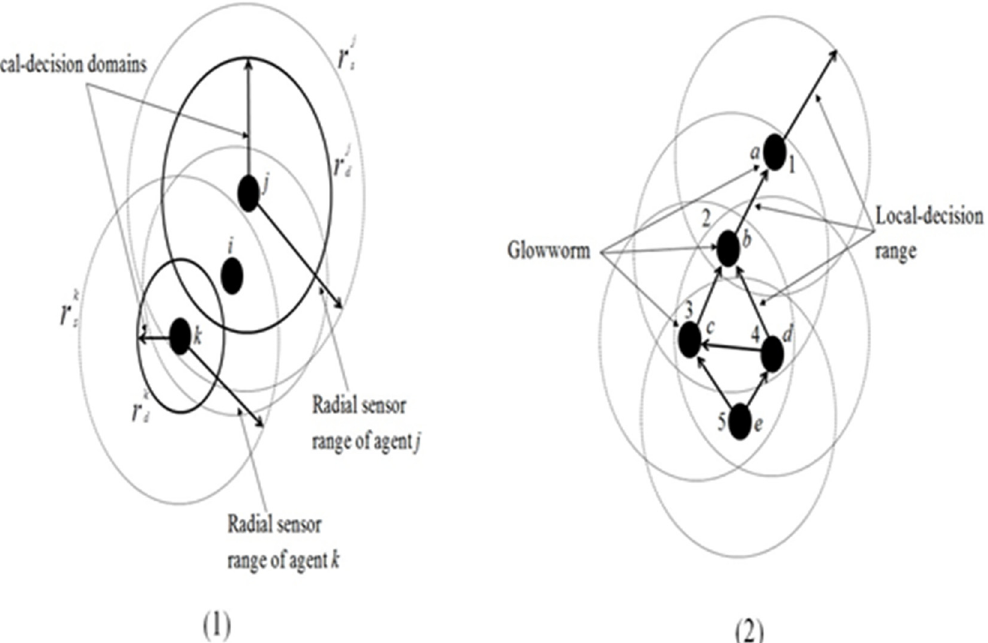
Fig 6. Glowworm Search Optimization (GSO) in two possible conditions. a , b , c , d , e , f , i , j , and k are the glowworm agents. In Figure 6.1, figure illustrates three glowworm agents with different sensor range and local-decision range. It shows if agent within local-decision of other agent, the agent with lower luciferin values move towards agent with higher luciferin values. In Figure 6.2, glowworm agents are ranked based on their luciferin values with lower number represent higher luciferin values and higher number represent lower luciferin values [58].